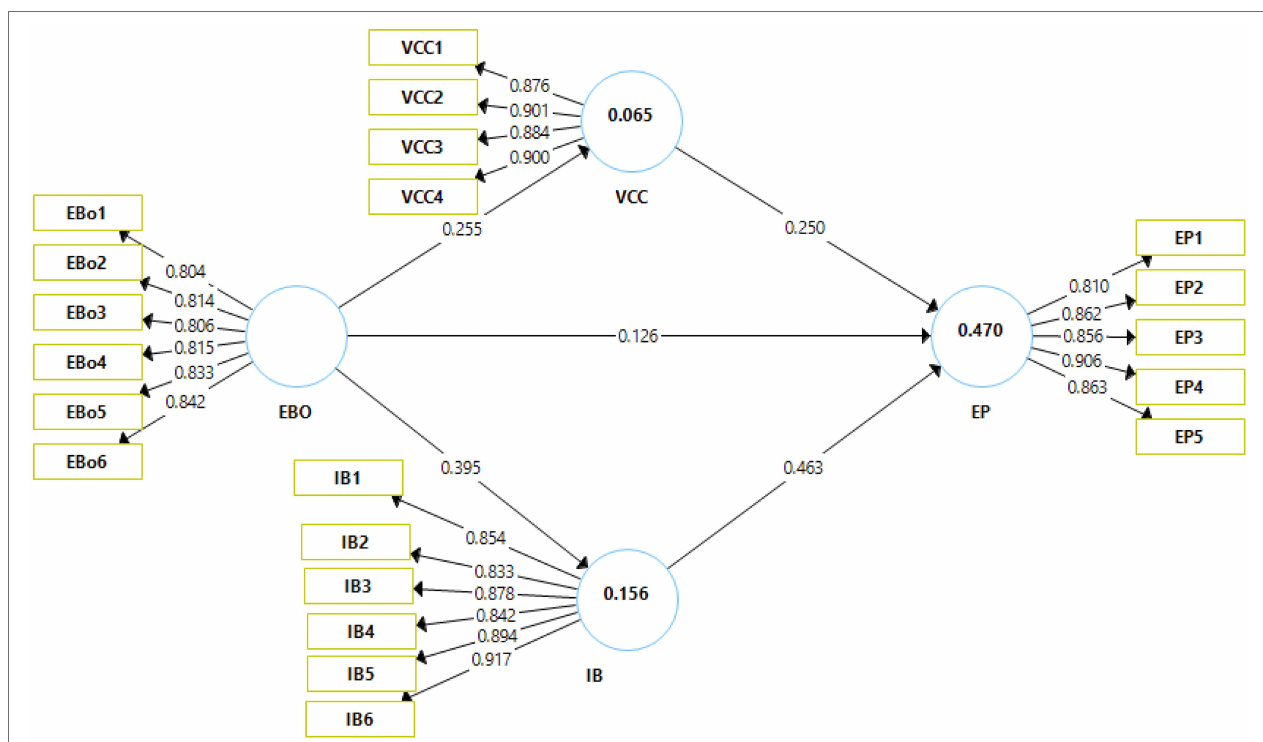
FIGURE 2 | Output of measurement model. EBO, enterprise brand orientation; VCC, customer value co-creation; IB, internal branding; EP, brand